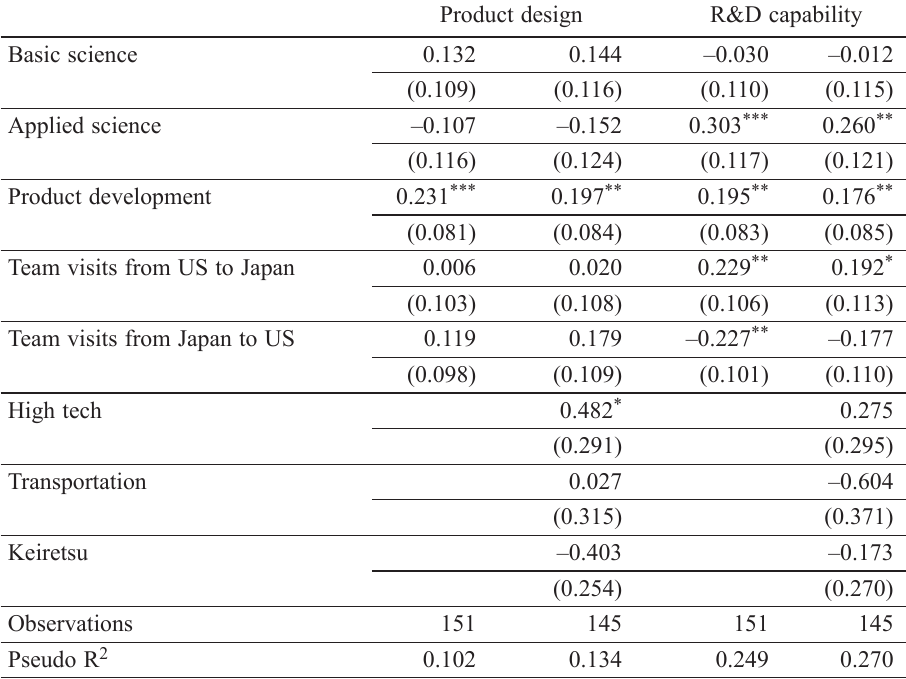
Table 5. Probit regressions: Intra-firm subsidiary to parent